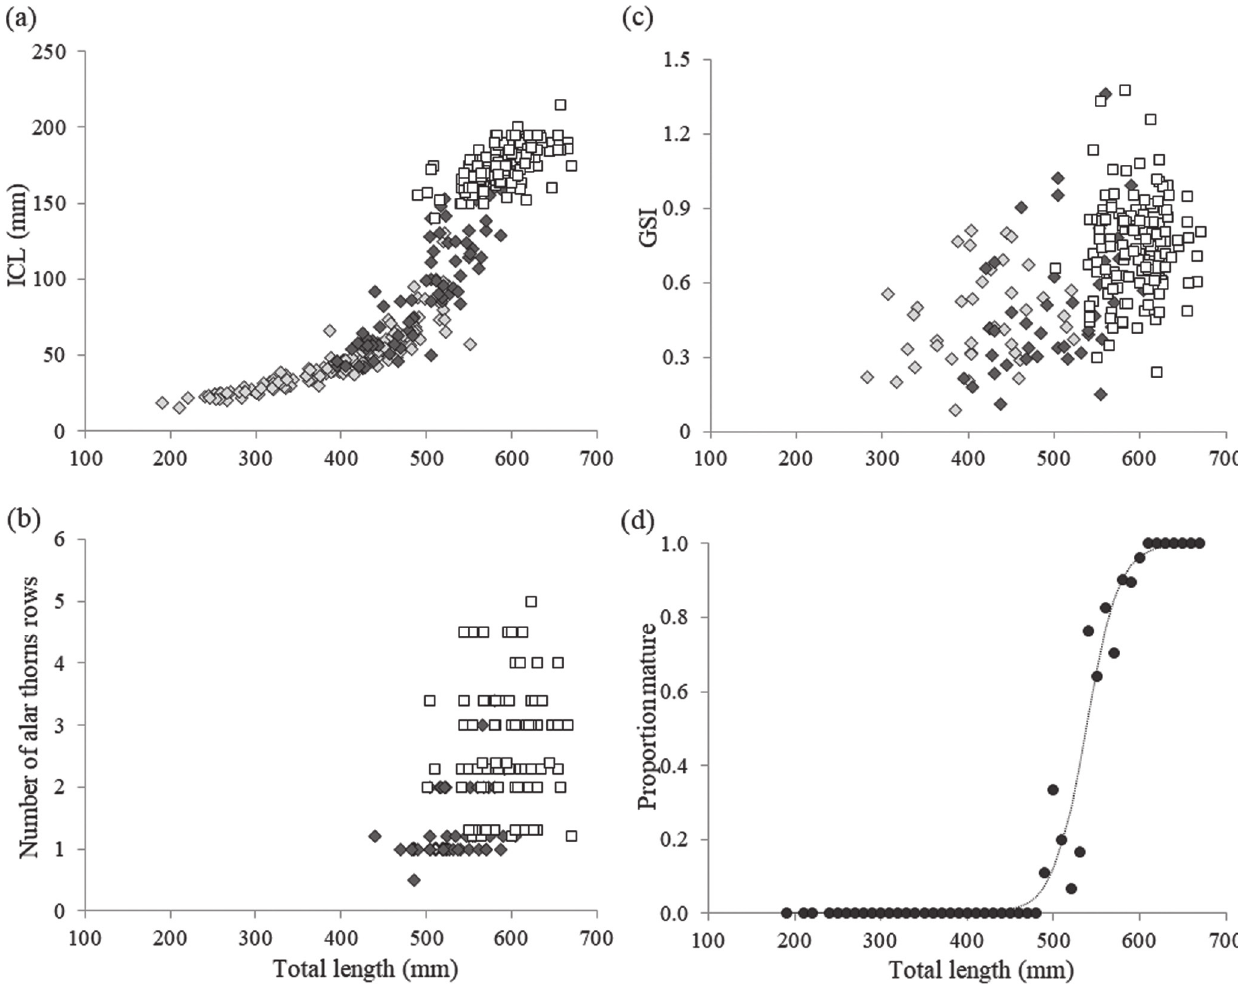
Fig. 4. Relationship between total length and a. inner claspers length (ICL); b . number of alar thorns rows; c. GSI; and d. proportion by mature individuals of Atlantoraja cyclophora males according to maturity stage (stage 1, light rhombus; stage 2, dark rhombus; stage 3, light